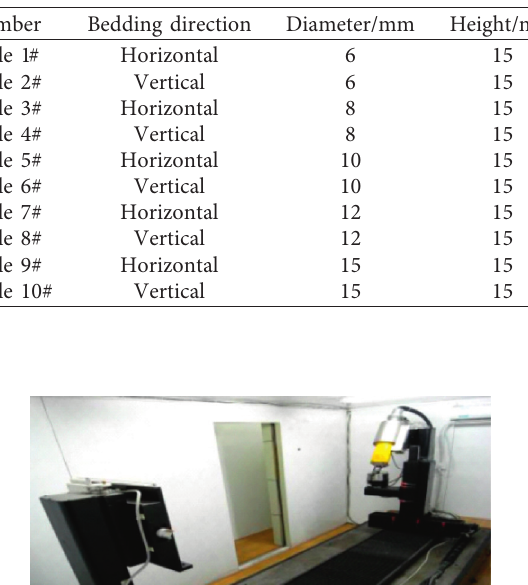
Table 1: The size parameters of shale samples.